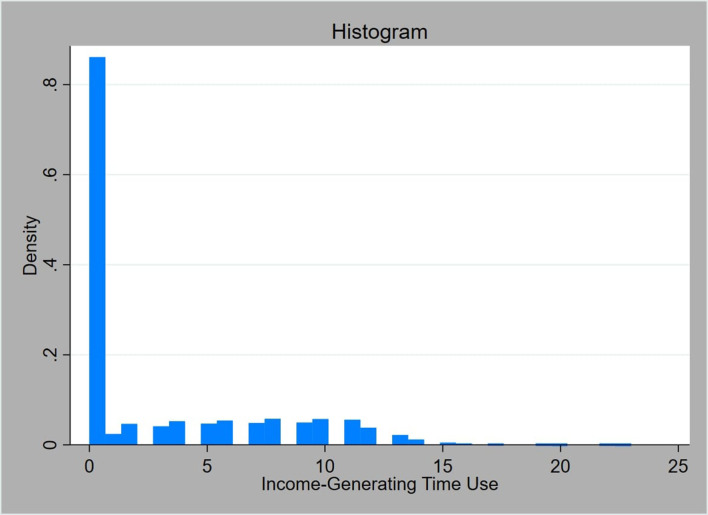
Histogram: income-generating time use.